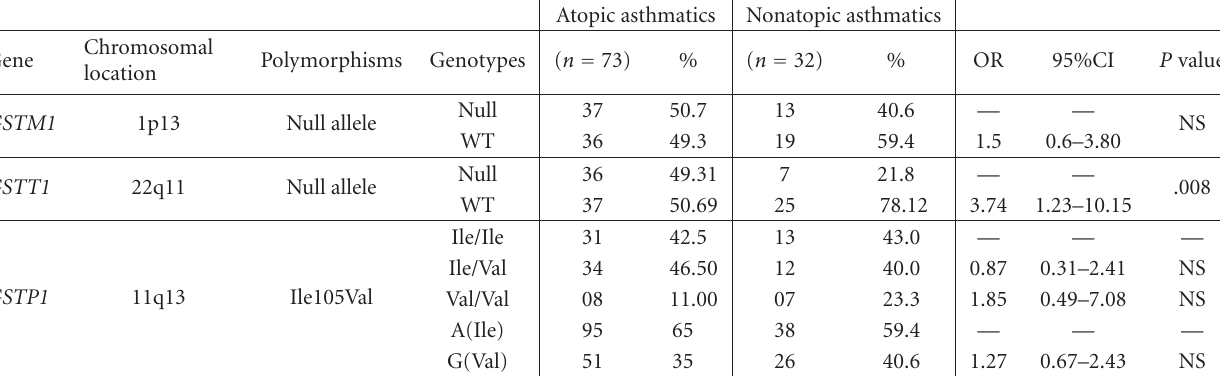
Table 3: Association between genotype profile and atopic asthma. NS: P value > .